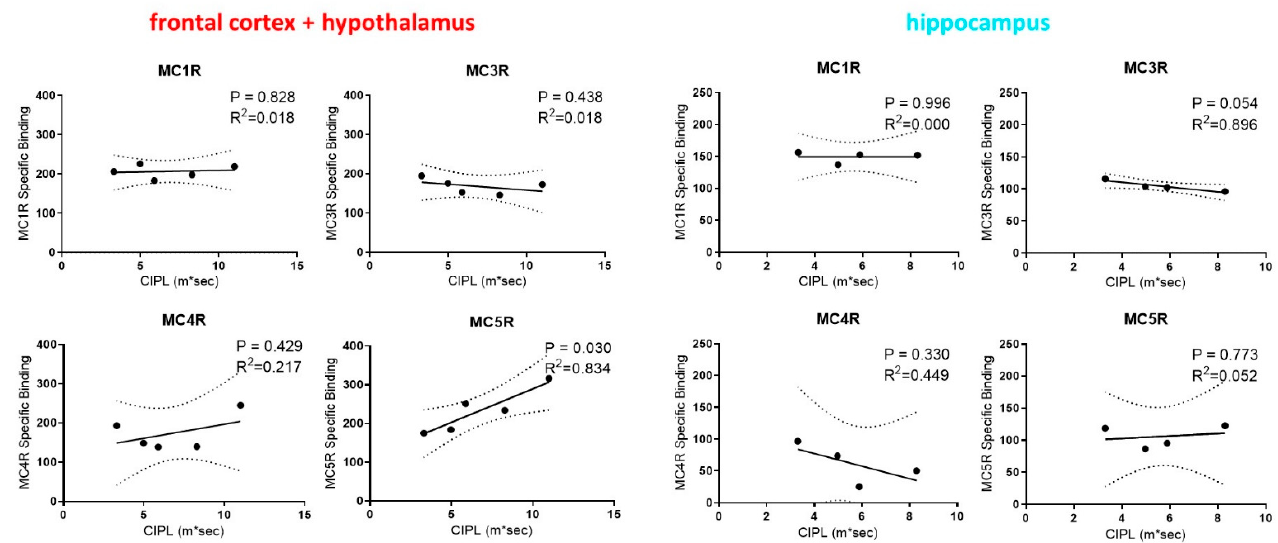
Figure 5. Linear correlations between the expression levels of different melanocortin receptor subtypes in the hippocampus and the frontal cortex/hypothalamus regions in the brains of young (6 mo) rats and their performance in spatial learning and memory as measured by the Correlated Integrated Path Length (CIPL) in the Morris swim task.